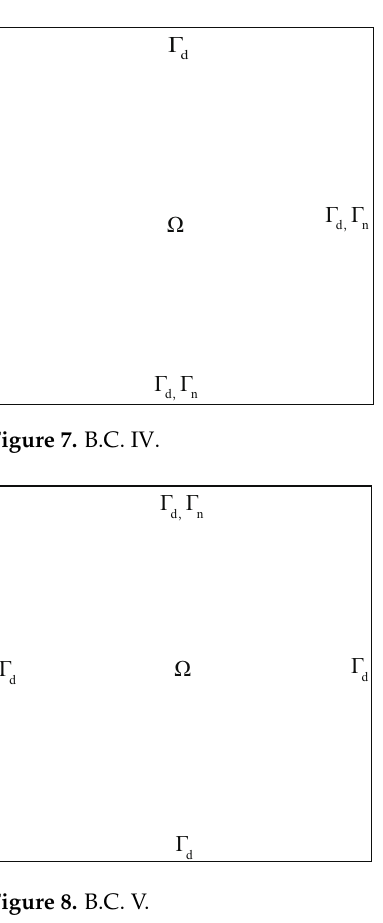
Figure 7. B.C. IV Figure 8. B.C. V